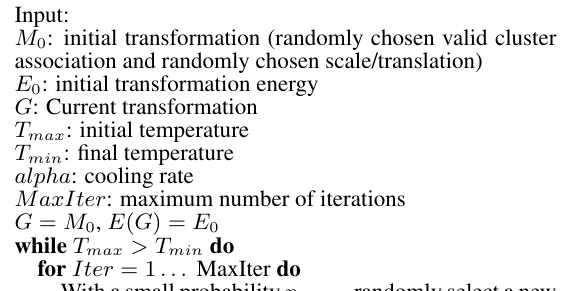
Algorithm 3 Simulated